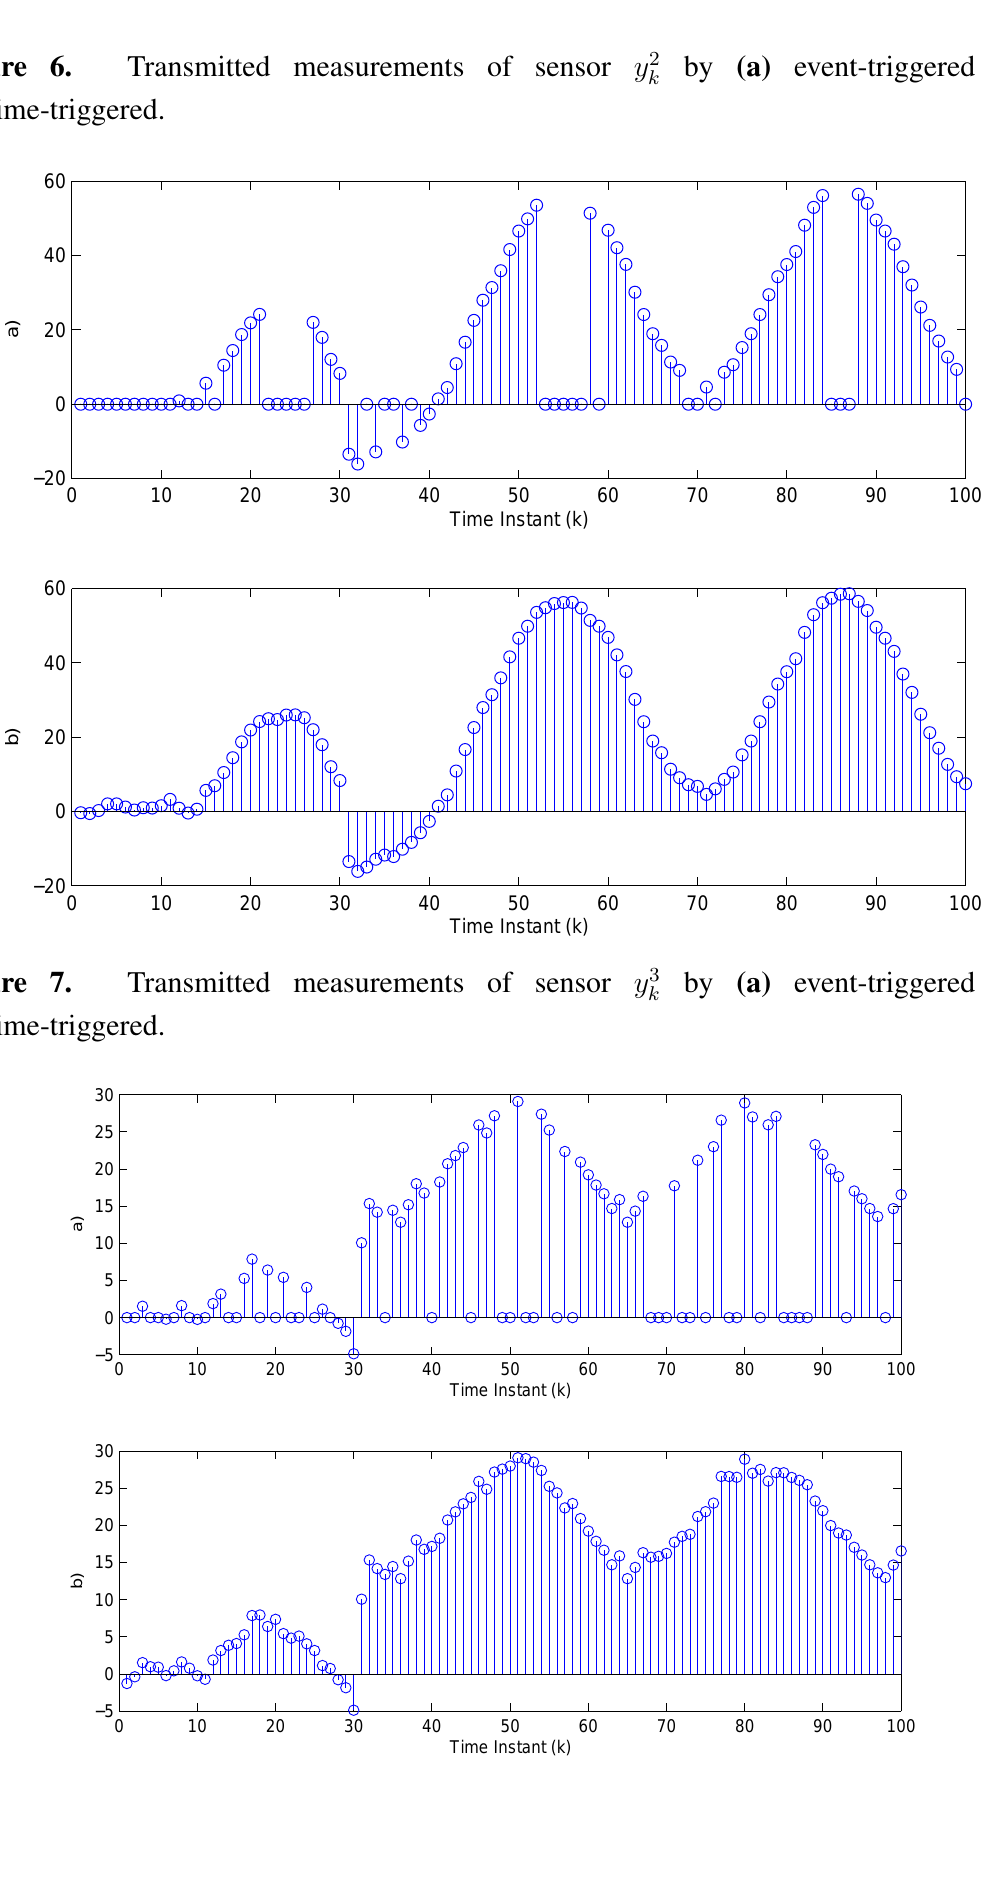
by (a) event-triggered and k